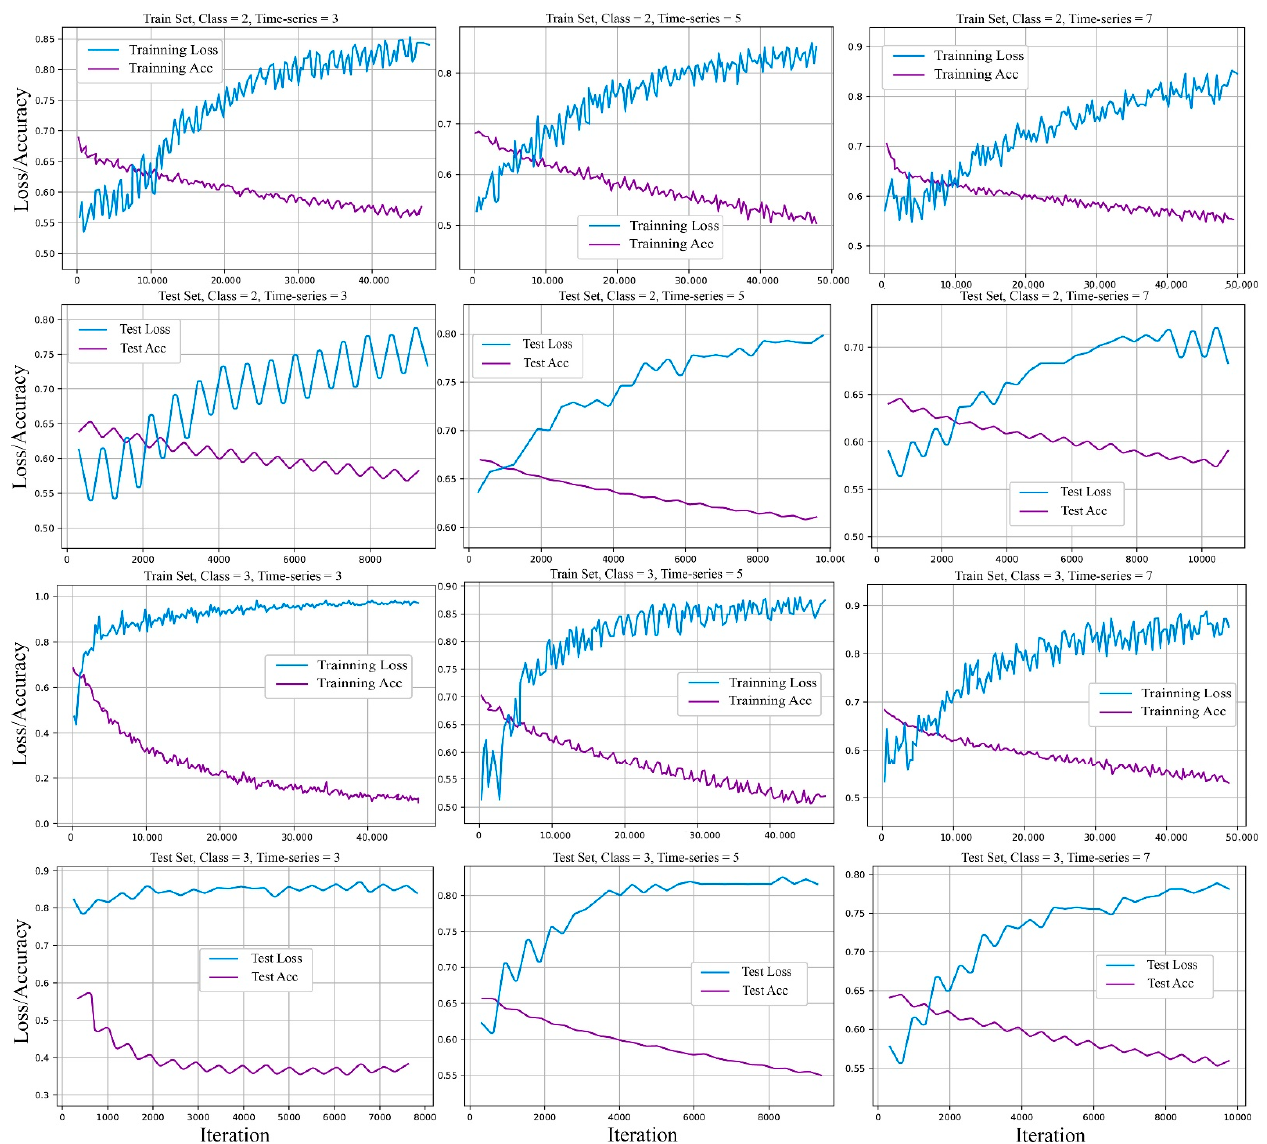
Figure 7. Loss and accuracy of the SF-TCN model training set and test set under different classification strategies and time series lengths.